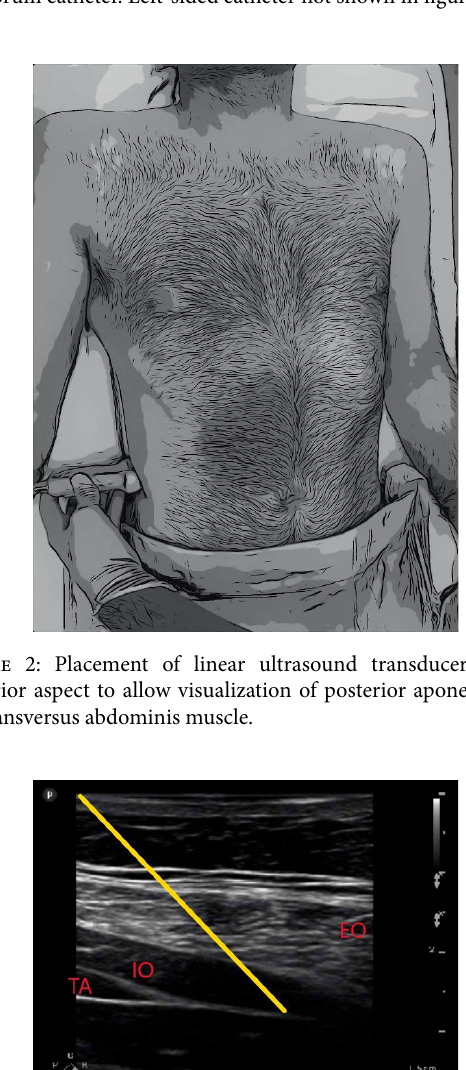
Figure 1: Patient with “J” incision and right-sided quadratus lumborum catheter. Left-sided catheter not shown in figure.